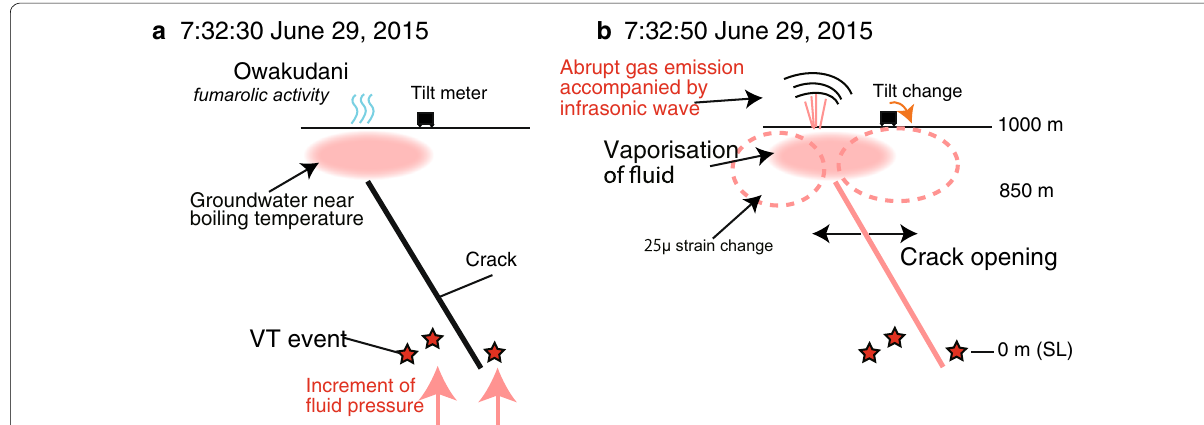
Fig. 5 Schematic illustration of the occurrence of an infrasonic wave accompanied by the crack opening. a The abrupt increase in the seismic amplitude occurred at 07:32:30 on June 29, 2015. b The infrasonic wave was generated coincident with the crack opening after 07:32:50